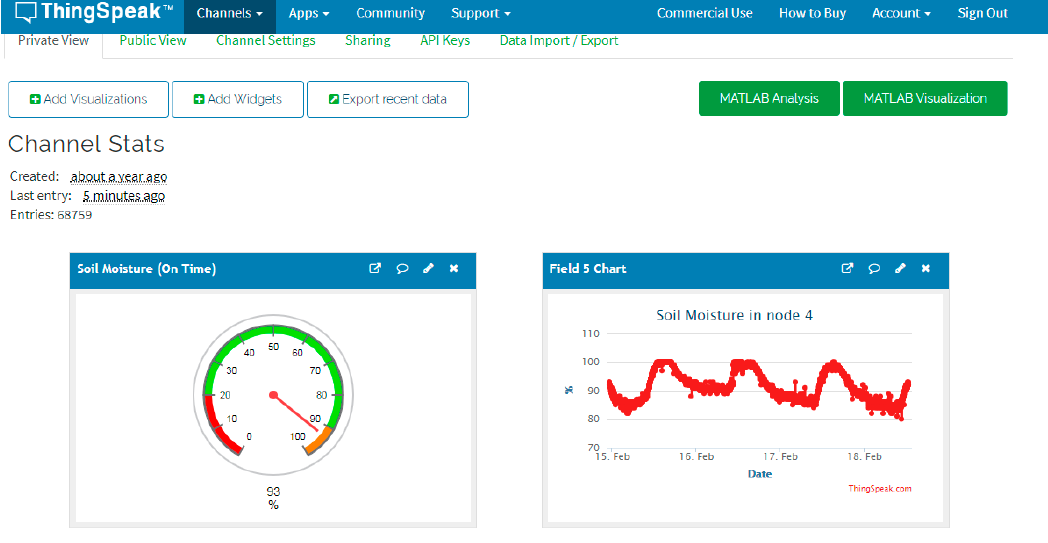
Table 8. Total equipment costs.